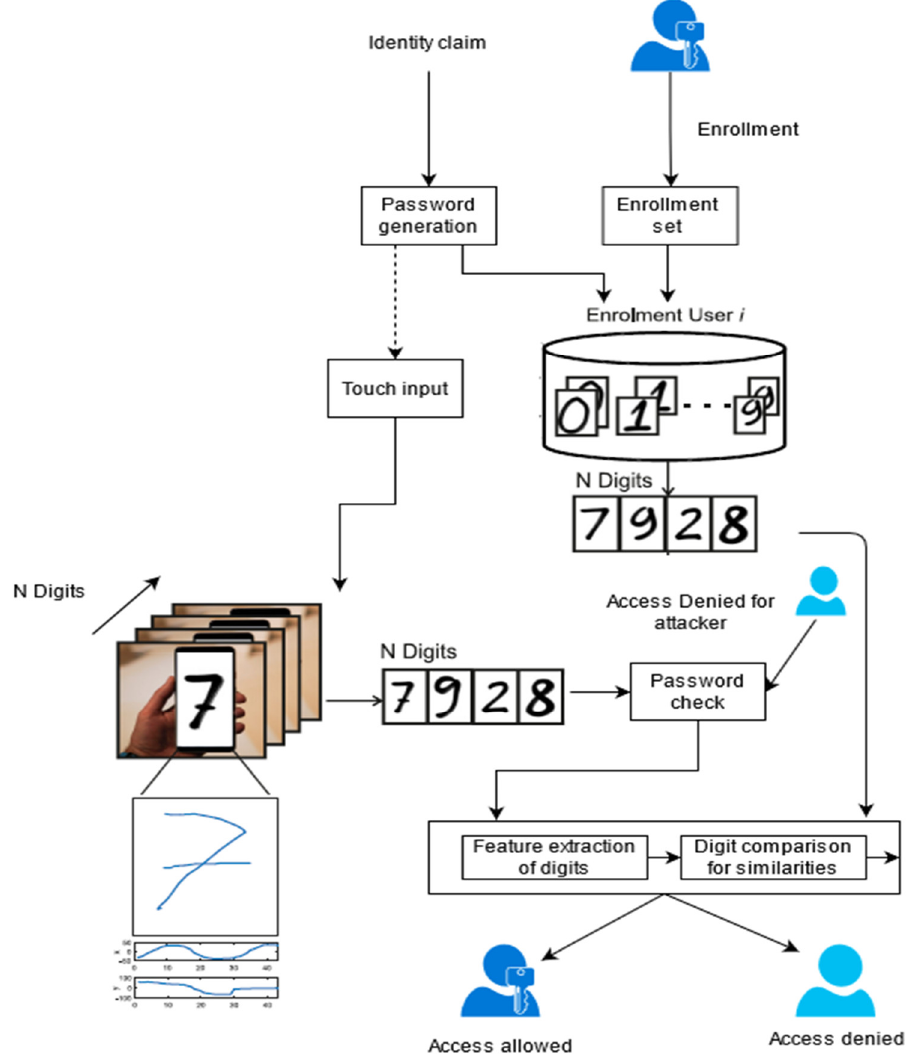
Figure 3. Proposed model for handwritten authentication.